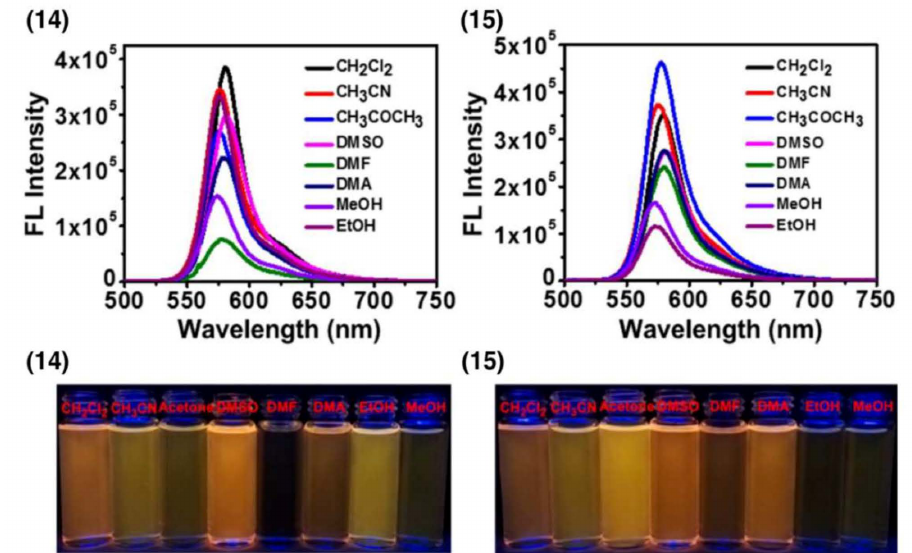
Figure 3. Fluorescence spectra of metallocycles 14 and 15 in different solvents ( λ ex = 556 nm, c = 1.00 µ M). Photographs of 14 and 15 under UV lamp at 365 nm in different solvents. Adapted from